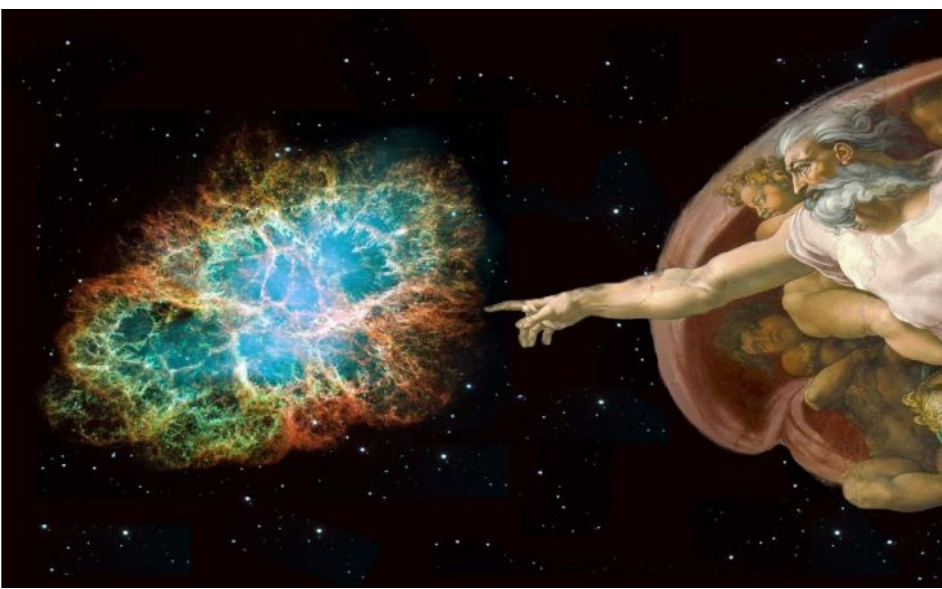
Figure 1. Artistic representation of God’s creation of the Universe.